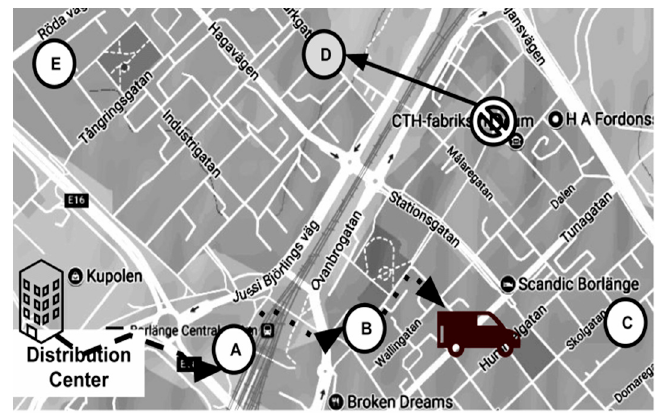
Figure 4. Consumer communication.